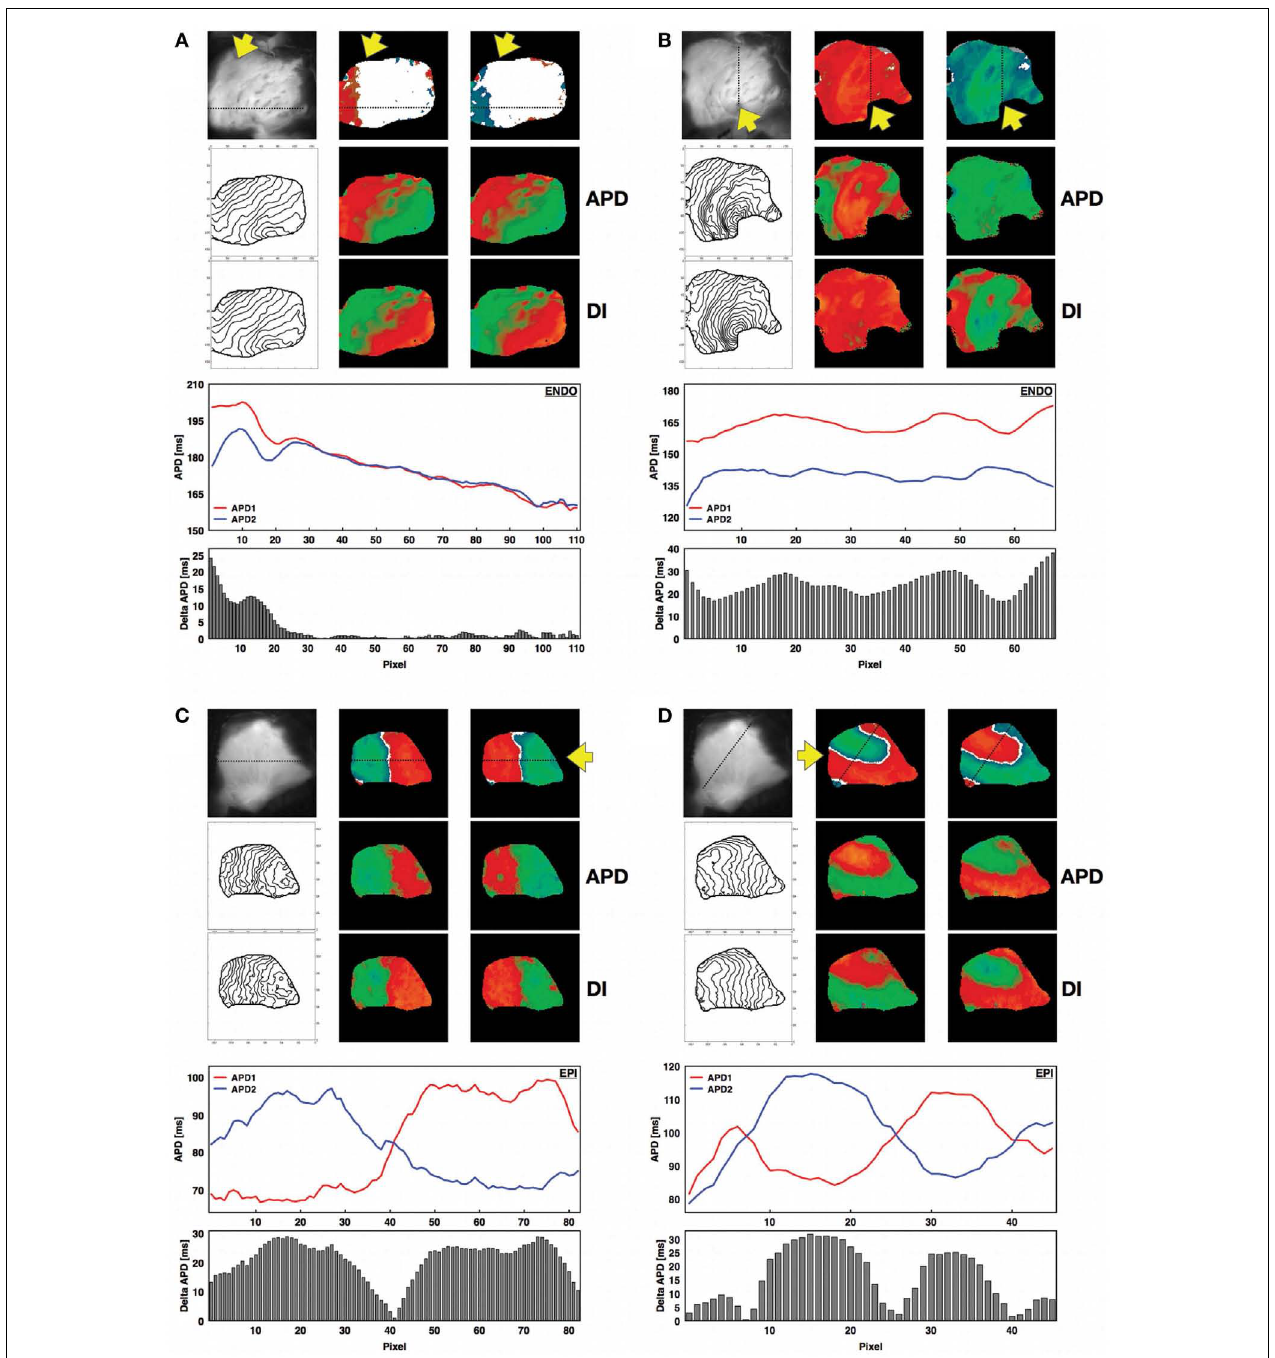
each pixel. (A) Regional concordant alternans (beats 18–19, CL = 400ms, APD = [143–212]ms, DI = [176–237]ms, endocardium, main axis 7cm), (B) global concordant alternans (beats 13–14, CL = 220ms, APD = [114–173]ms, DI = [63–136]ms, endocardium, main axis 7cm), (C) global discordant alternans with one node (beats 19–20, CL = 110ms, APD = [63–107]ms, DI = [26–74]ms, epicardium, main axis 6cm), (D) global discordant alternans with multiple (three) nodes (beats 37–38, CL = 150ms, APD = [70–124]ms, DI = [25–82]ms, epicardium, main axis 6cm). Figure S2 in the Supplementary Material shows nodal patterns for all the beats. (A,B) Recordings are from endocardium, while (C,D) are from epicardium. Similar behavior was observed on both